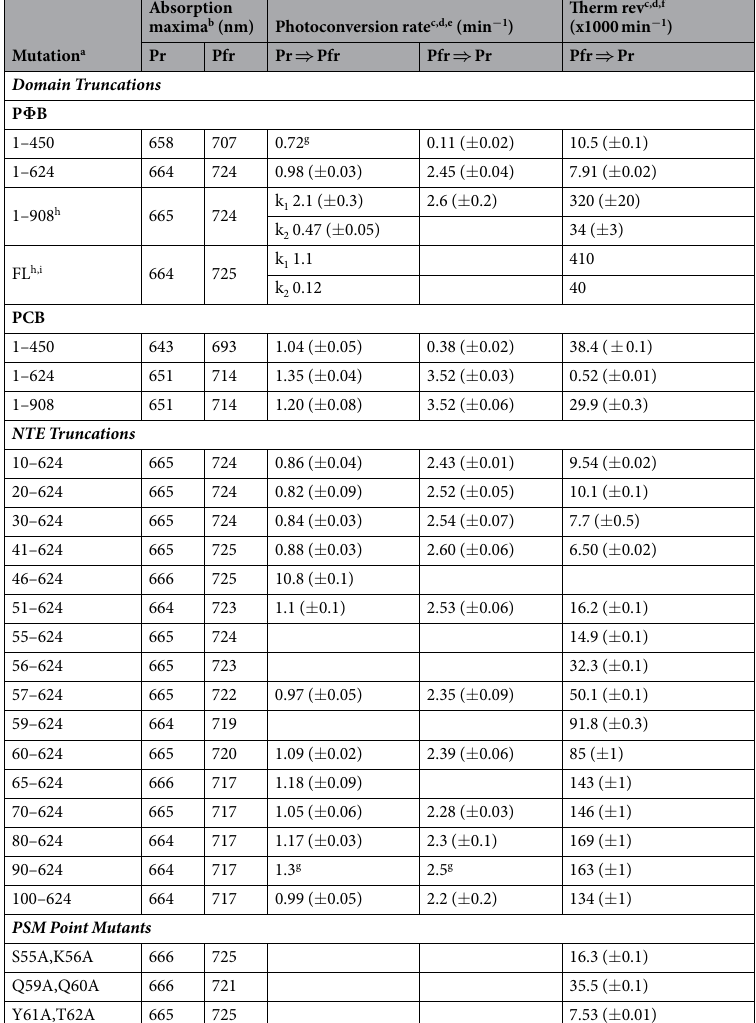
Table 1. Spectral and Kinetic Constants of Truncation and Point Mutants of Arabidopsis PhyB. a Data were collected from PhyB containing the indicated residues after removal of the N-terminal 6His-TEV tag. b Maxima of the Q absorption band. Pfr maxima were identified from difference spectra generated by subtracting red-irradiated from dark-adapted samples. c Calculated from the global fit of absorption at 640 nm, 650 nm, 660 nm, 670 nm, 700 nm, 710 nm, 720 nm, 730 nm, and 740 nm as a function of time using the equation: Abs = Δ